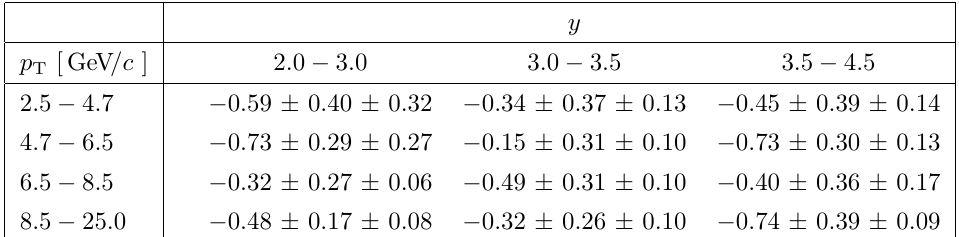
Table 4 . Values of the D + and systematic uncertainty for each of the D +